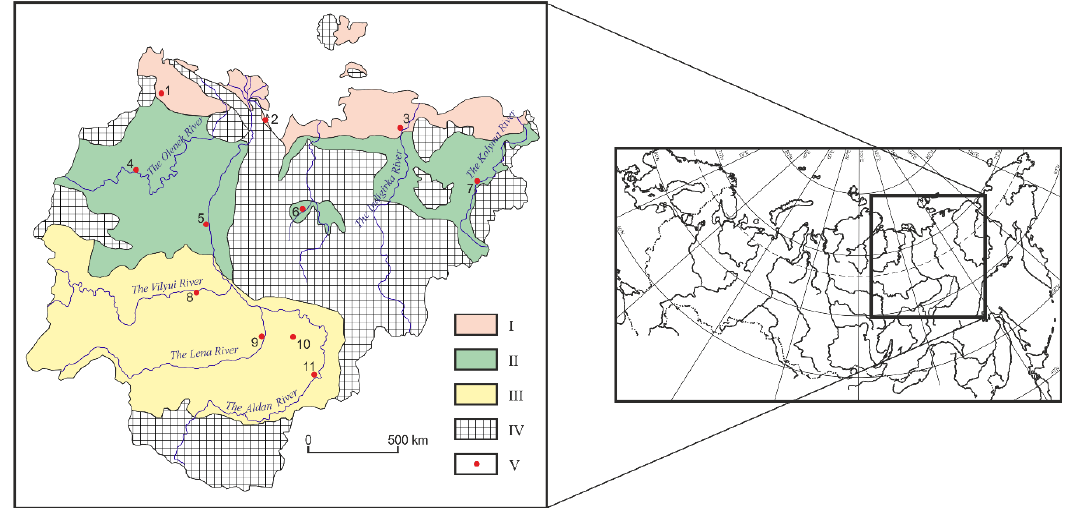
Figure 1. Map of the explored permafrost landscapes of Yakutia: I — tundra, II — northern taiga, III — middle taiga, IV — mountain and high plateau areas, V — meteorological station (1 — Saskylakh, 2 —